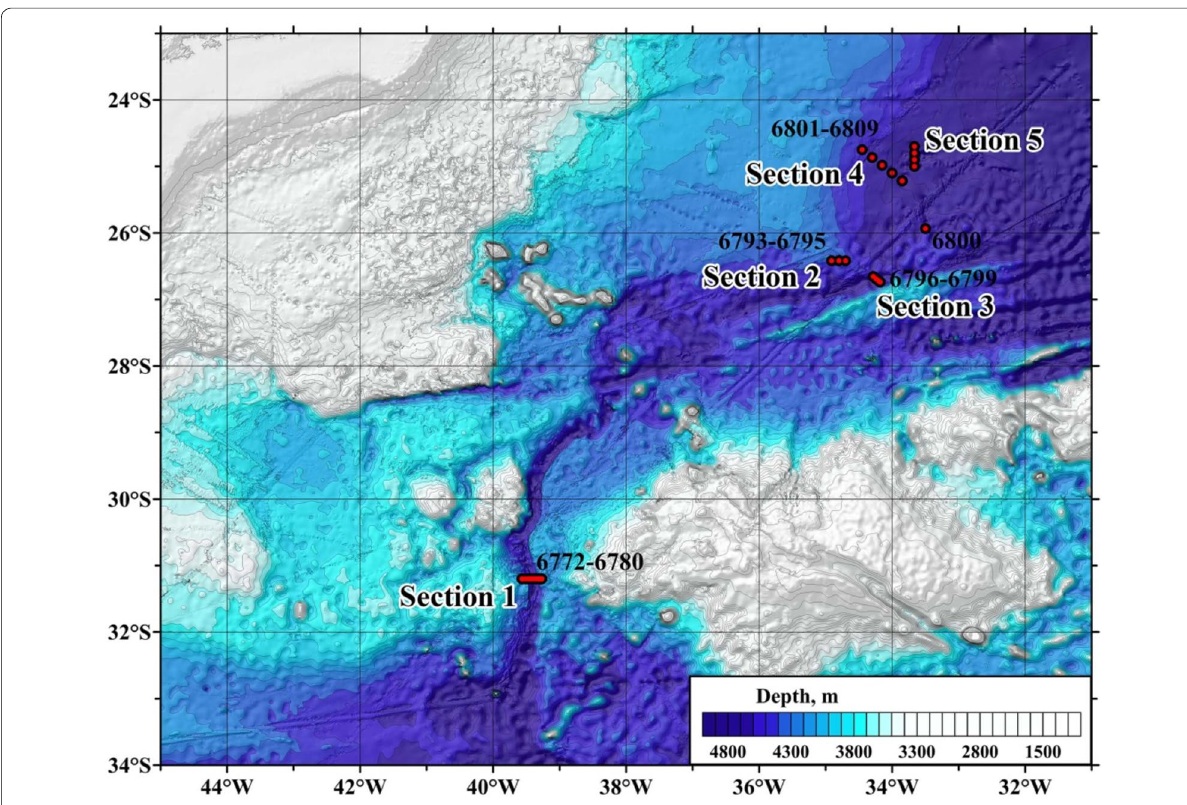
Fig. 1 Topography of the Vema Channel and its continuation. The numbers of stations in 2020 are